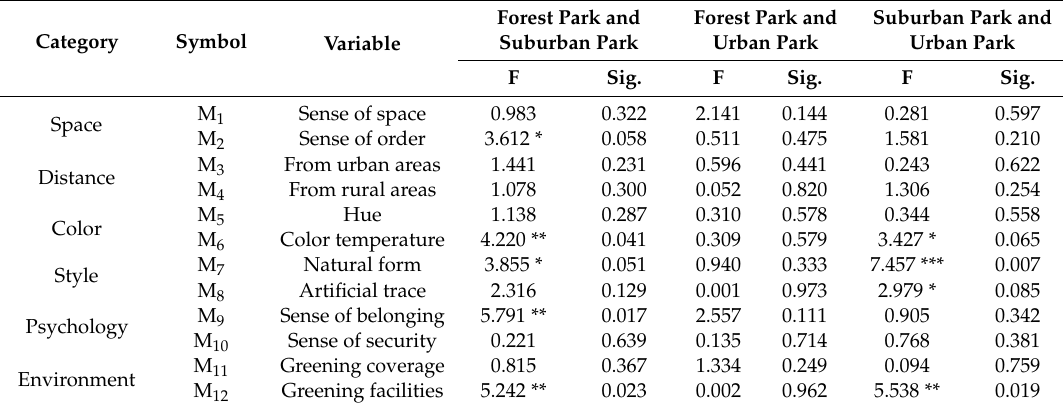
Table 3. Independent samples test of spatial image perception of urban forests in